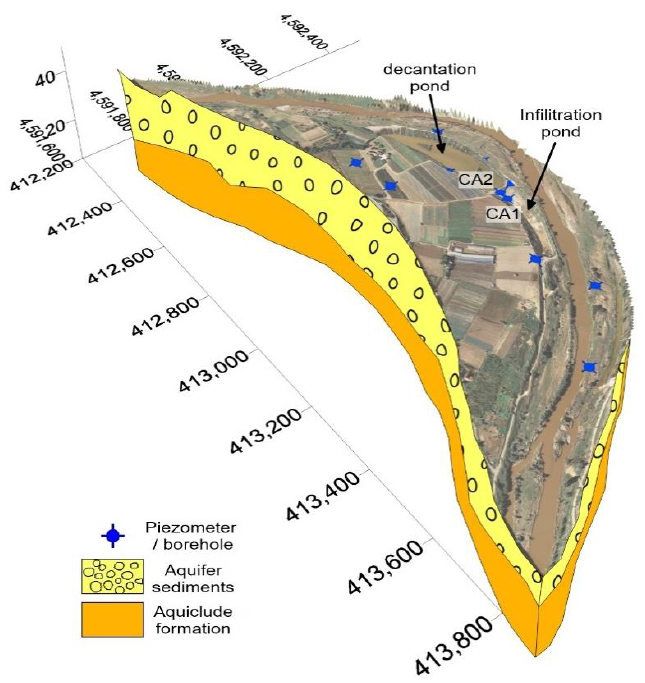
Figure 10. Geometry of the aquifer derived from the integration of ERT and boreholes data. Distances are in meters.